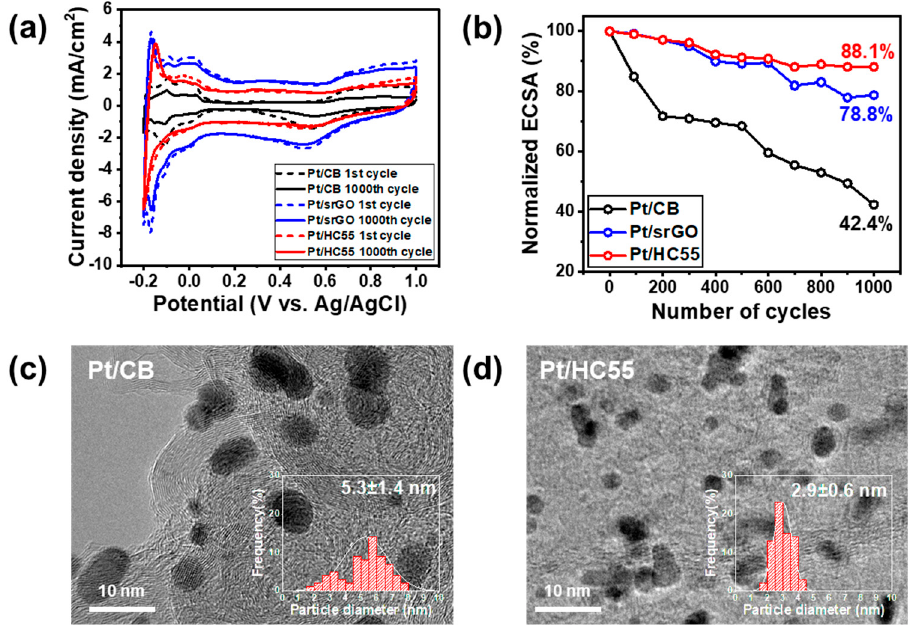
Figure 5. ( a ) CV curves of Pt/srGO, Pt/HC55, and Pt/CB before and after 1000 cycles of ADT in N 2 − saturated 0.5 M H 2 SO 4 at scan rate of 50 mV/s. ( b ) Normalized ECSAs of catalysts measured over 1000 cycles of ADT. TEM images and Pt particle size distribution histograms of ( c ) Pt/CB and ( d ) Pt/HC55 after 1000 cycles of ADT.